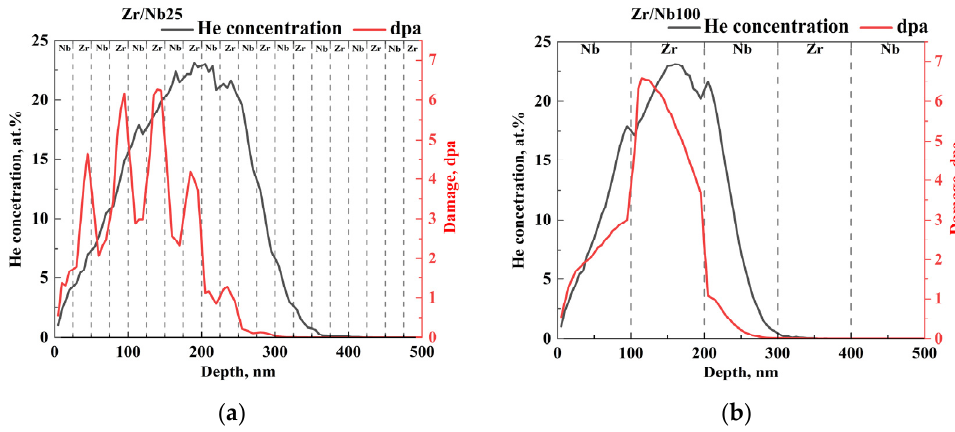
Figure 1. Helium ion and damage distribution in Zr/Nb NMCs 25/25 ( a ) and Zr/Nb NMCs 100/100 ( b ) as calculated by SRIM-2013 code.